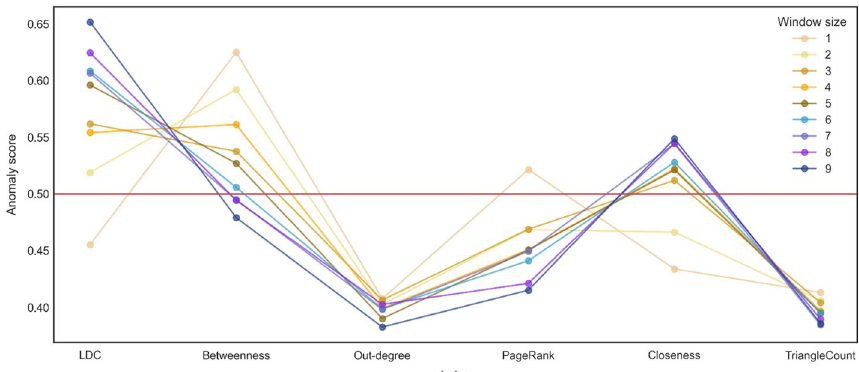
Fig. 6 IsolationForest to detect anomalies. The x-axis represents different centrality measures, and the y-axis represents the anomaly score. Each line represents the anomaly score for any centrality measure for a given WS